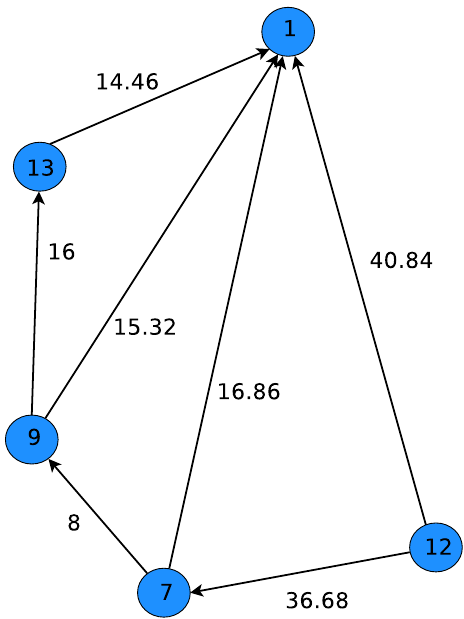
Figure 5. Selective CTP links originating from node